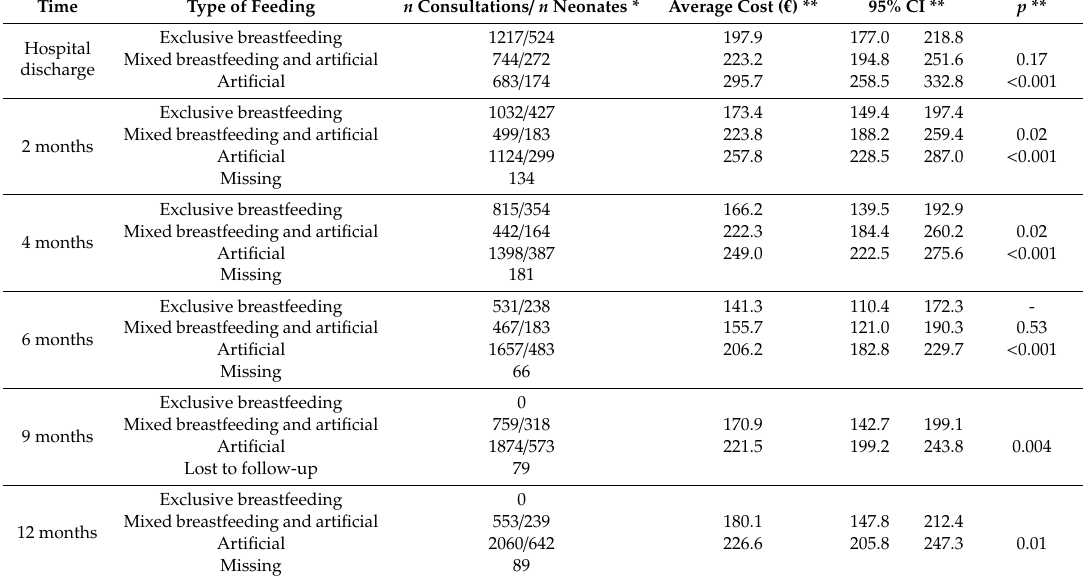
Table 2. Relationship between type of feeding and costs due to consultations in primary care.